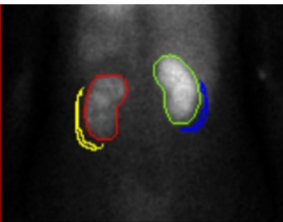
Figure 1. Demonstration of the region of interest (ROI) when calculating the glomerular filtration rate (GFR) by Gate’s method from a 33-year-old woman. The ROIs for each kidney were drawn manually via the compression posterior image. Background subtraction was drawn by placing a semilunar ROI in the outer-lower of each kidney